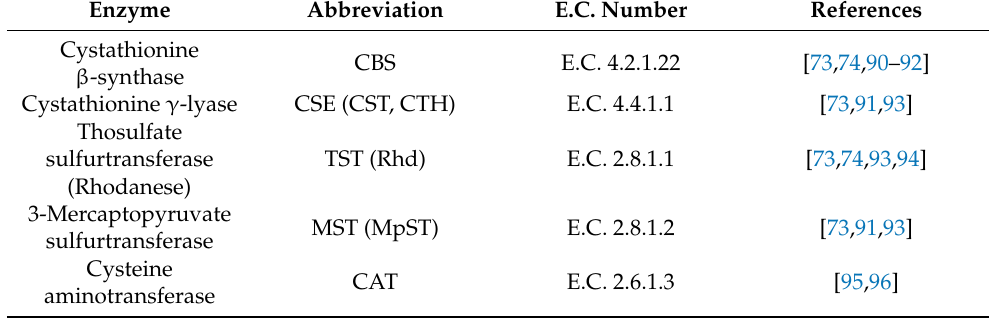
Table 3. Enzymes involved in cysteine/methionine metabolism, persulfidation/transsulfuration.